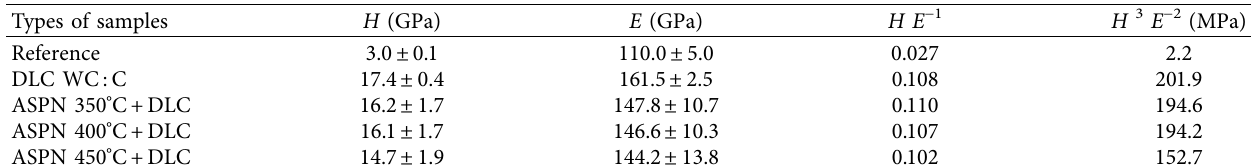
Figure 3: GDOES concentration depth profles of nitrogen over the ASPN+DLC concentration profle. Table 1: Reference, DLC WC:C, and ASPN+DLC nanoindentation results for hardness ( H ), Young’s modulus ( E ), and their relationship H E − 1 and H 3 E − 2 .